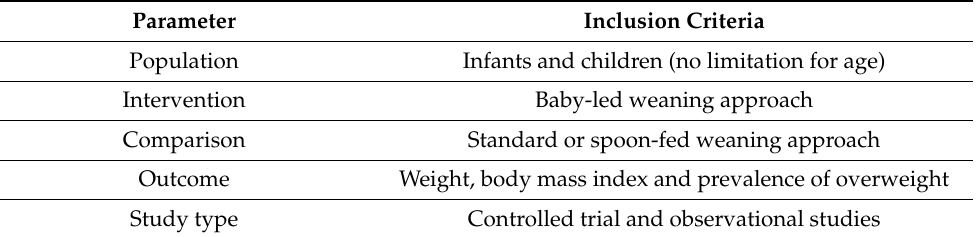
Table 1. PICOS (Population, Intervention, Comparison, Outcome and Study type) criteria for the inclusion of studies. Parameter Inclusion Criteria Population Infants and children (no limitation for age) Intervention Baby-led weaning approach Comparison Standard or spoon-fed weaning approach Outcome Weight, body mass index and prevalence of overweight Study